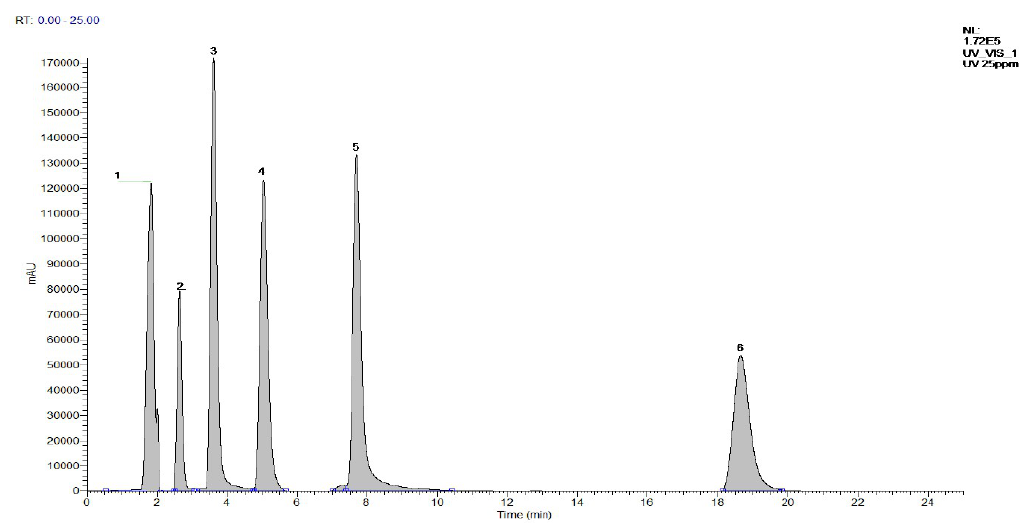
Figure 1. The MRM chromatogram of the six tested compounds in a mixed standard solution (fortified at LOQ level) operated in positive mode. Peaks are in order as follows: 1: Caffeic acid, 2: Quercetin, 3: Apigenin, 4: Ferulic acid, 5: Baicalein, and 6: Kaempferol.